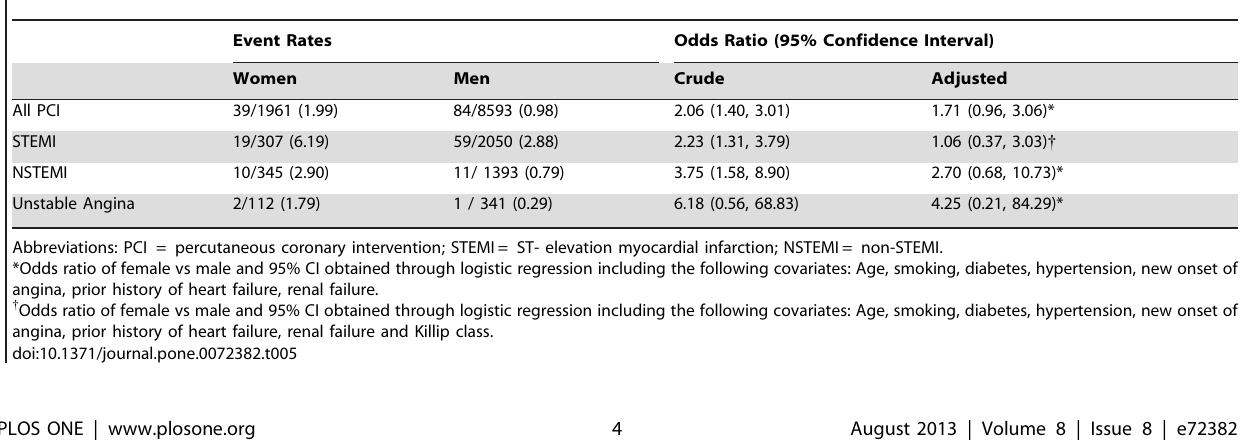
Table 5. In hospital mortality for women compared to men.